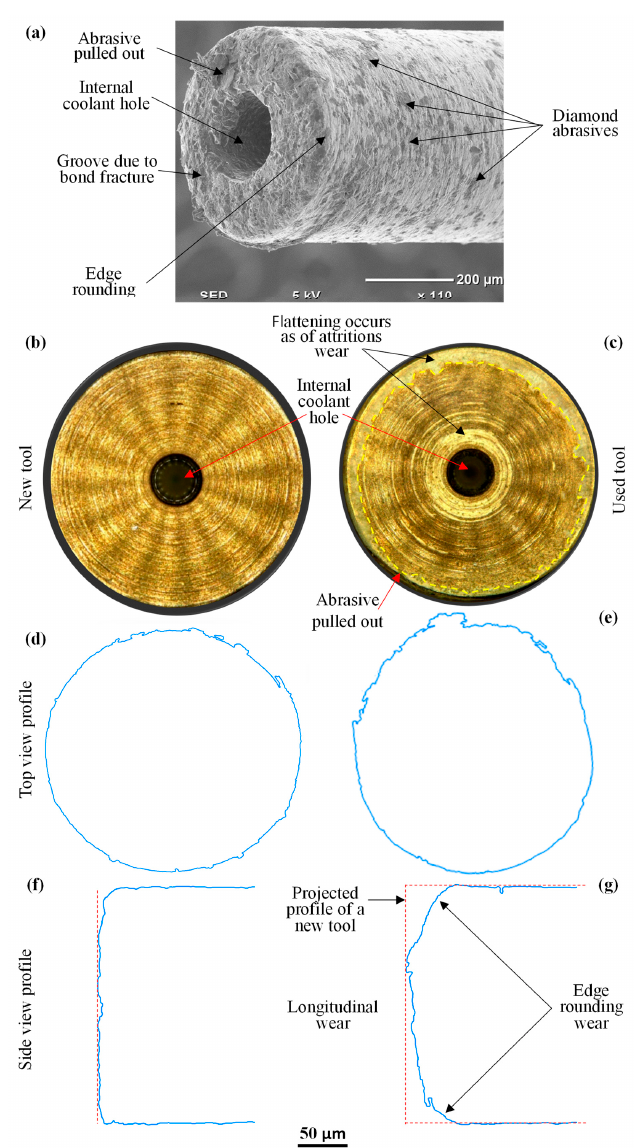
Figure 16. Tool wear: ( a ) a 3D view of the used RUM tool; ( b ) end cutting face of the new RUM tool; ( c ) end cutting face of the used RUM tool; ( d ) end face profile of the new tool; ( e ) end face profile of the used tool; ( f ) side face profile of the new tool; and ( g ) side face profile of the used